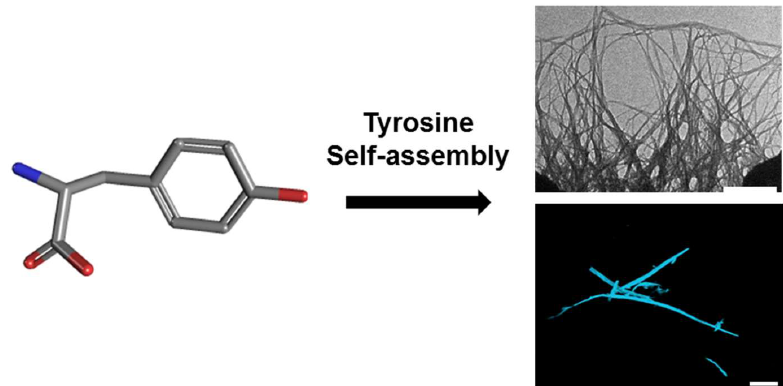
Figure 1. Tyrosine molecular self-assembly. ( Left ) Molecular scheme of monomeric L -Tyr. ( Right ) Transmission electron microscopy (TEM; scale bar: 500 nm; ( top )) and confocal microscopy following ThT binding (scale bar: 100 µm; ( bottom )) images of L -Tyr self-assembled ordered supramolecular fibrils.